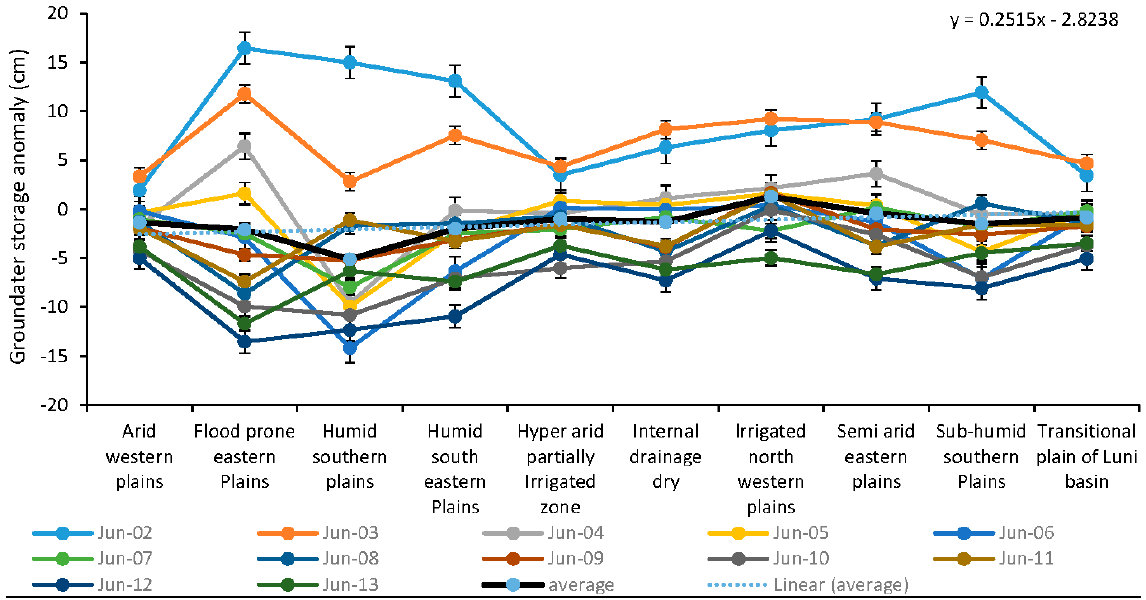
Figure 9. Variations in agroclimatic zonal GRACE estimates of groundwater storage anomaly in the Indian state of Rajasthan for the month of June. Bars indicate standard